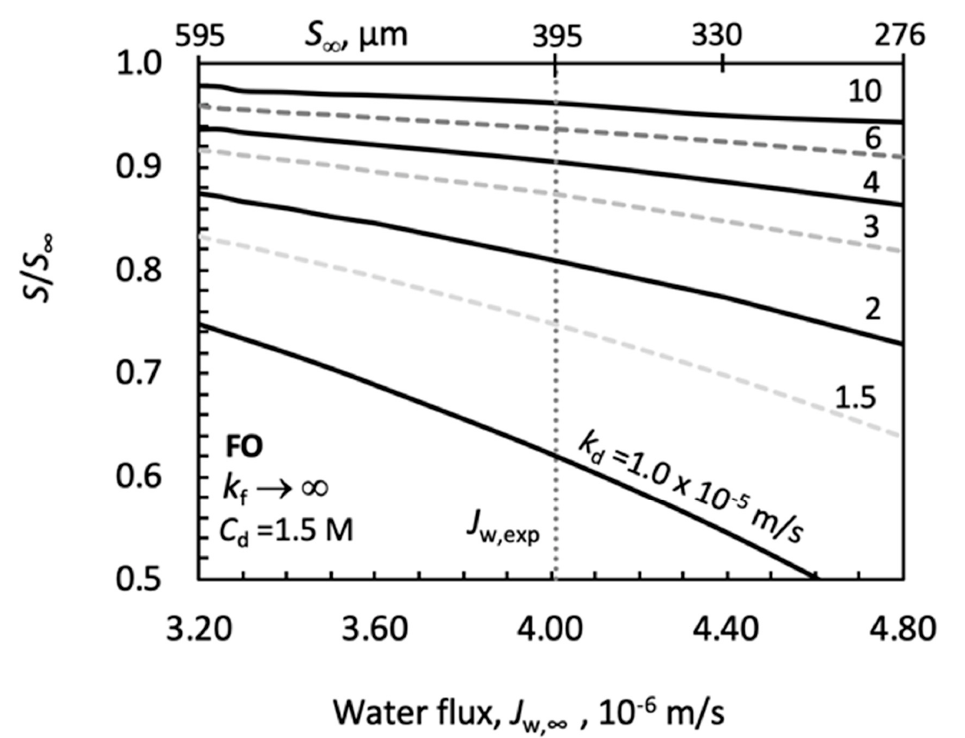
Figure 11. Change of the S/S ∞ values as a function of the water flux in the FO system, taking into account ±20% error of the measured data, at C d =1.5 M, k f → ∞ applied data of Manickam and McCutcheon [40] (other parameters are given in caption of Figure 10). On the upper horizontal axis, the calculated value of the corresponding structural parameter, S ∞ , is given for k d → ∞ , k f → ∞ .